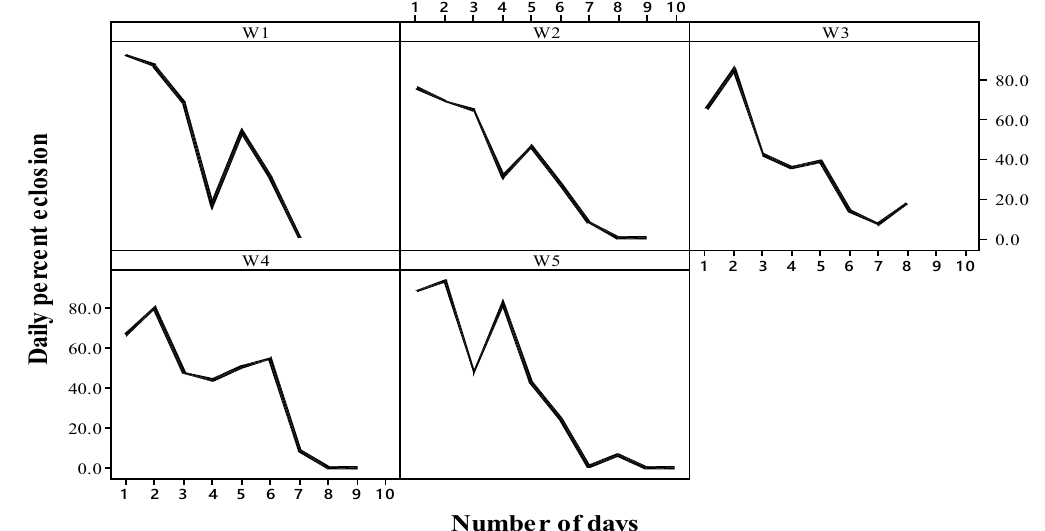
Figure 3: Daily eclosion patterns of R. microplus females under four weight categories (W1 to W5).